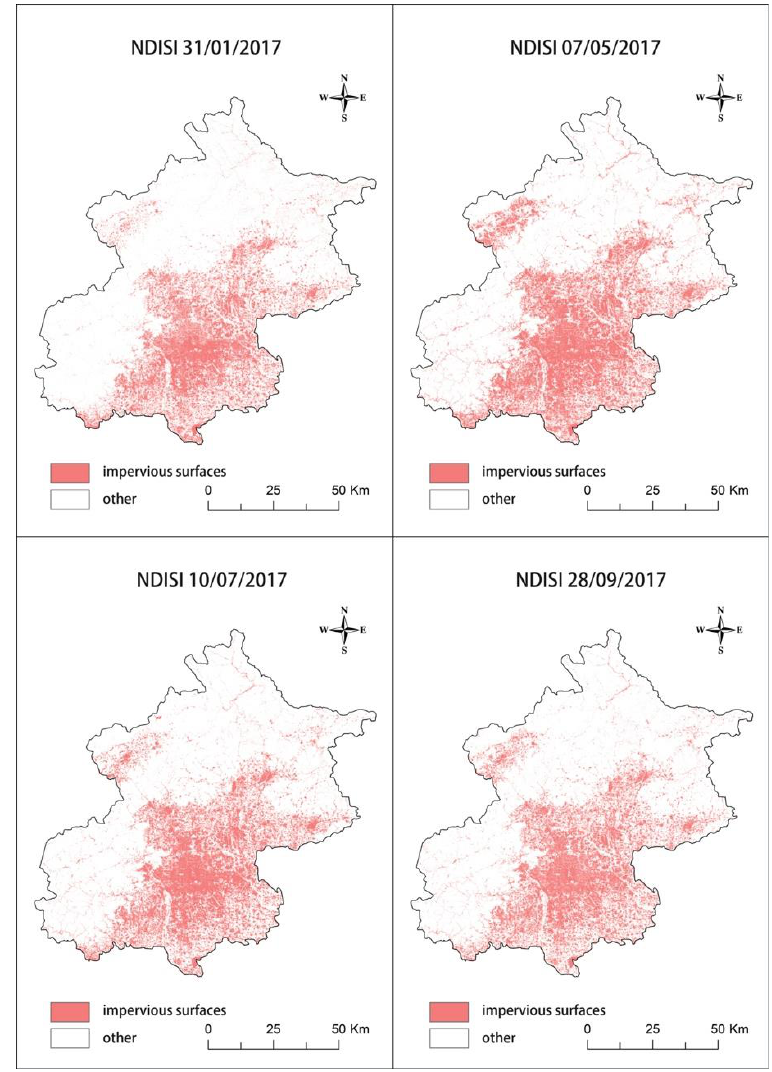
Figure 4. The VCs of Beijing: 31 January 2017, 7 May 2017, 10 July 2017, and 28 September 2017.